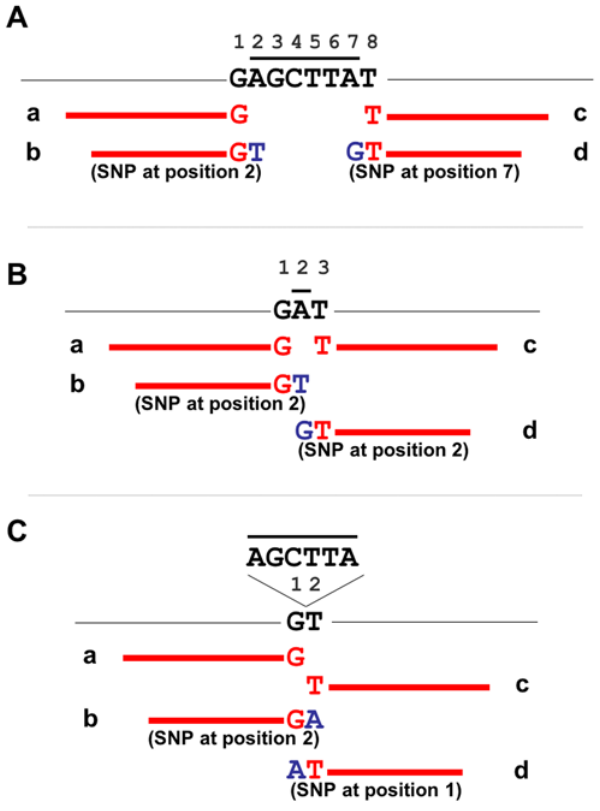
Figure 5. Deletions and insertions can be detected using SNP_search. (A) The genome sequence is indicated by a thin black line, with eight genomic nucleotides, GAGCTTAT, explicitly shown. Nucleotides are arbitrarily numbered above the sequence from 1 to 8. Thicker black bar, nucleotides deleted in the genome from which the sequence reads were generated. Red lines, sequence reads, where the terminal nucleotides of the read are indicated either in red or blue. Blue nucleotides indicate that the nucleotide is not contiguous with the adjacent red nucleotide in the reference genome, but is adjacent to the red nucleotide in the genome being sequenced. Four sequence reads derived from the genome being sequenced and flanking or traversing the deletion site will be recognized by ‘galign’. Sequences ‘a’ and ‘c’ will flank the deleted region, whereas sequences ‘b’ and ‘d’ will span the deletion. For sequence ‘b’, nucleotides 1 and 8 of the reference genome Figure 4. Expected stochastic occurrences of unread genomic are adjacent in the sequenced genome because of the deletion of sequence stretches. The number of expected unread sequences of a nucleotides 2–7. ‘galign’ will read this as a mismatch at position 2 of the minimum length is plotted for a genome of size 100 Mbps and 40 reference genome. Likewise, for sequence ‘d’, ‘galign’ will read a million 32-nt sequence reads. The probability, P , of obtaining an unread mismatch at position 7 of the reference genome. Occasionally, deletion- sequence of at least length L is equal to the probability of not obtaining spanning reads will happen to have the same sequence as the reference any 32-bp sequence fragments that cover a stretch of length L . This is genome lacking the deletion. This will not change the analysis (cid:1) (cid:2) n , where G is the genome size, S is the given by P ~ G { S { L z 1 described in the text because a deletion-spanning read can (nearly) G sequence read length (32), and n is the number of sequence reads always be found that will be called as a mismatch. (B), same as A, except examined. The expected number of deletions is then given approx- that a single nucleotide deletion is depicted. (C), same as A, except that imately by P | G . an insertion is